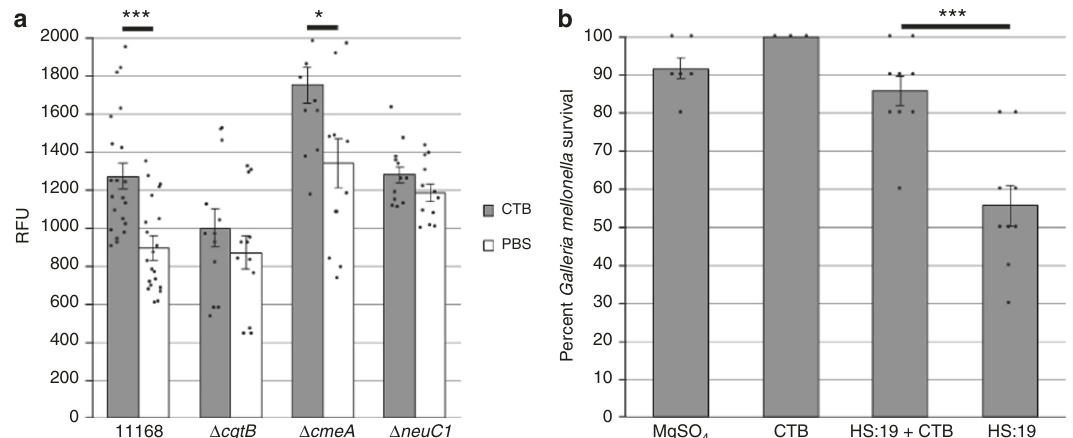
Fig. 5 Cholera toxin B subunit (CTB) increases membrane permeability and reduces C. jejuni virulence in the Galleria mellonella model. a C. jejuni 11168 wildtype ( n = 21 per condition), Δ cgtB ( n = 12 per condition), Δ cmeA ( n = 12 per condition) and Δ neuC1 ( n = 12 per condition) were incubated with ethidium bromide for 20 min following treatment with PBS (white) or CTB (gray) and the relative fl uorescence when exposed to CTB was measured. b G. mellonella larvae were inoculated with C. jejuni HS:19 alone ( n = 9) or together with CTB ( n = 9), MgSO 4 buffer alone ( n = 6), or MgSO 4 buffer together with CTB ( n = 3), and larvae survival rates were determined after 5 days. Error bars represent the standard error within each group. *** p -value ≤ 0.001, * p - value ≤ 0.05 determined by two-tailed t -test. Source data are provided as a Source Data fi